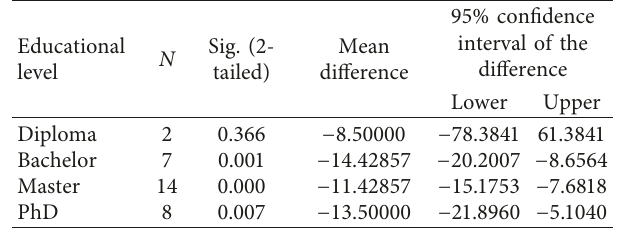
Table 7: Statistic and one-sample t -test for reduced personal ac- complishment with reference to years of experience.